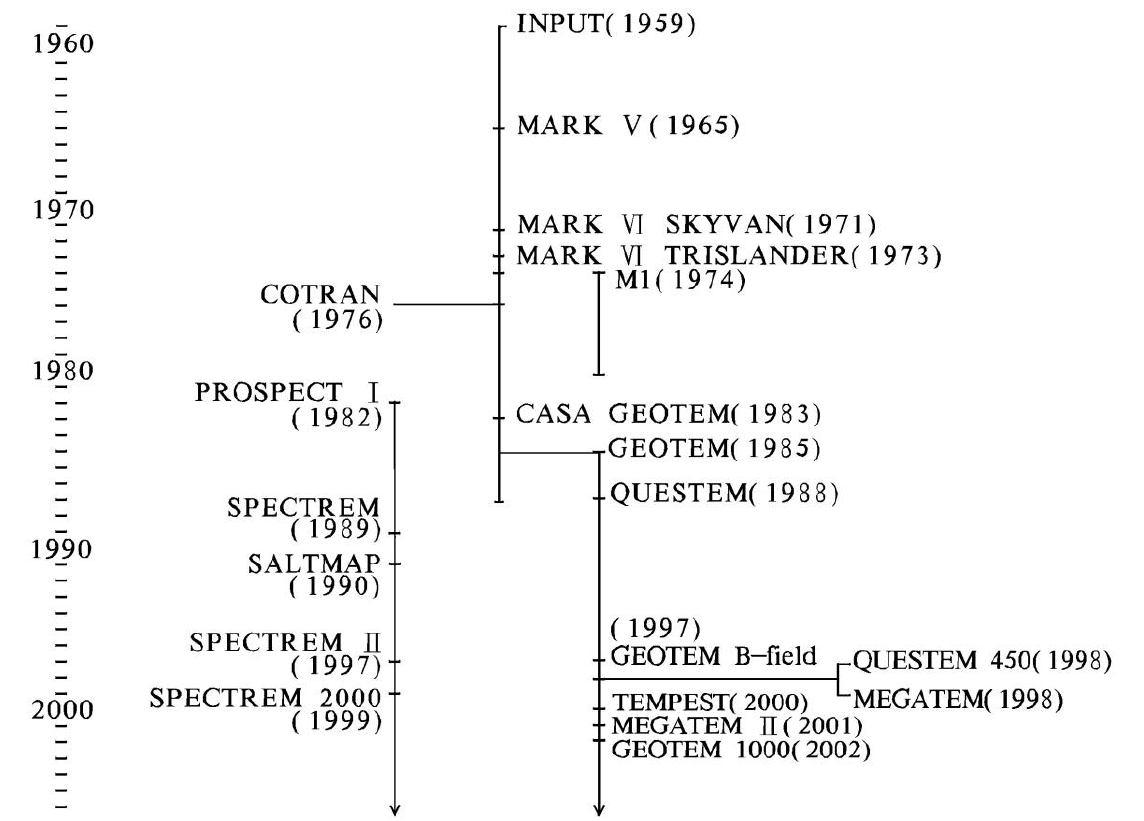
Figure 1 . Overview of FTEM system development milestones from 1959 to 2006. Figure 1. Overview of FTEM system development milestones from 1959 to